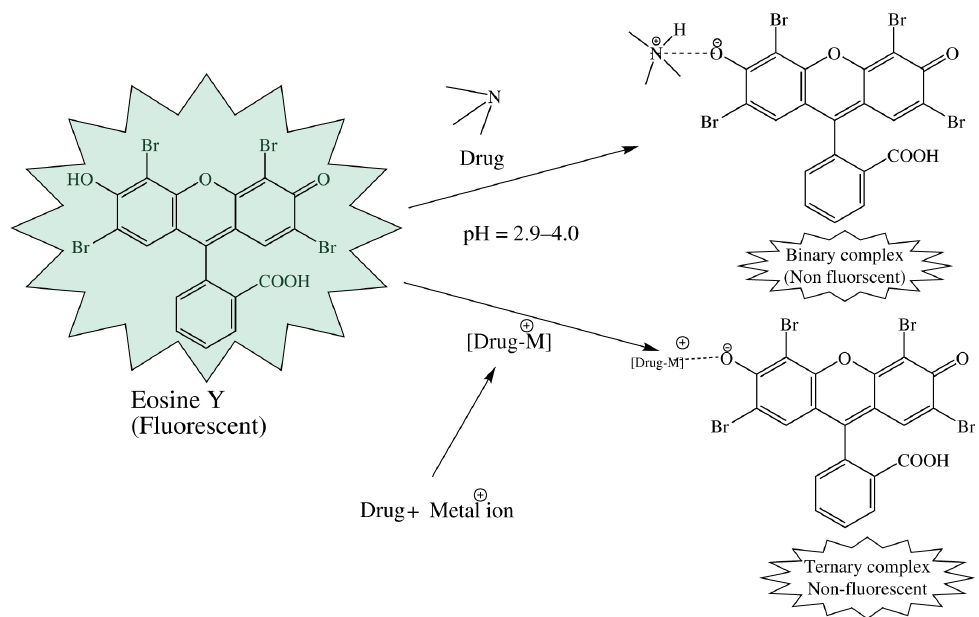
Figure 4: Fluorescence quenching of eosin Y by either binary or ternary complexes formation. Metal ion can be copper (Cu 2+ ), lead (Pb 2+ ), zinc (Zn 2+ ) or palladium (Pd 2+ ).